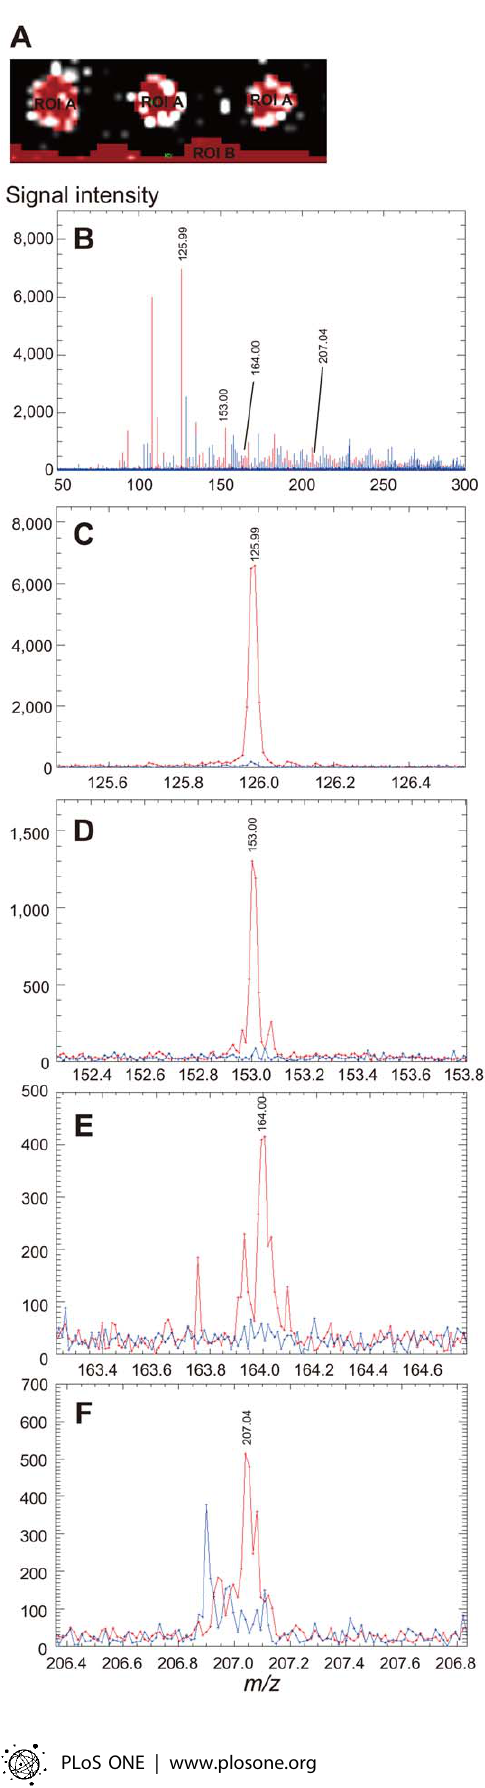
Figure 3. Hair-specific mass spectra of putative aging markers. ROI-specific mass spectra in subject No. 1 are presented. Red peaks and blue peaks are derived from the hair section and background area, respectively. (A) ROI selection is illustrated: ROI A as hair section and ROI B as background area. (B) m/z 50 to 300. (C) m/z 125.99. (D) m/z 153.00. (E) m/z 164.00. (F) m/z